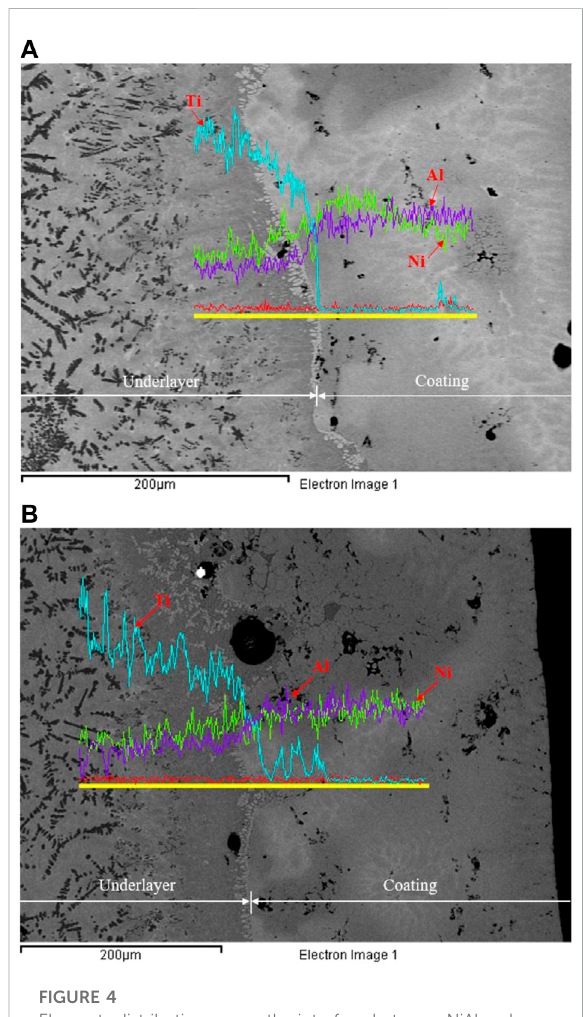
FIGURE 4 Elements distribution across the interface between NiAl and titanium using heating rates of (A) 46.6 K/s and (B) 57.0